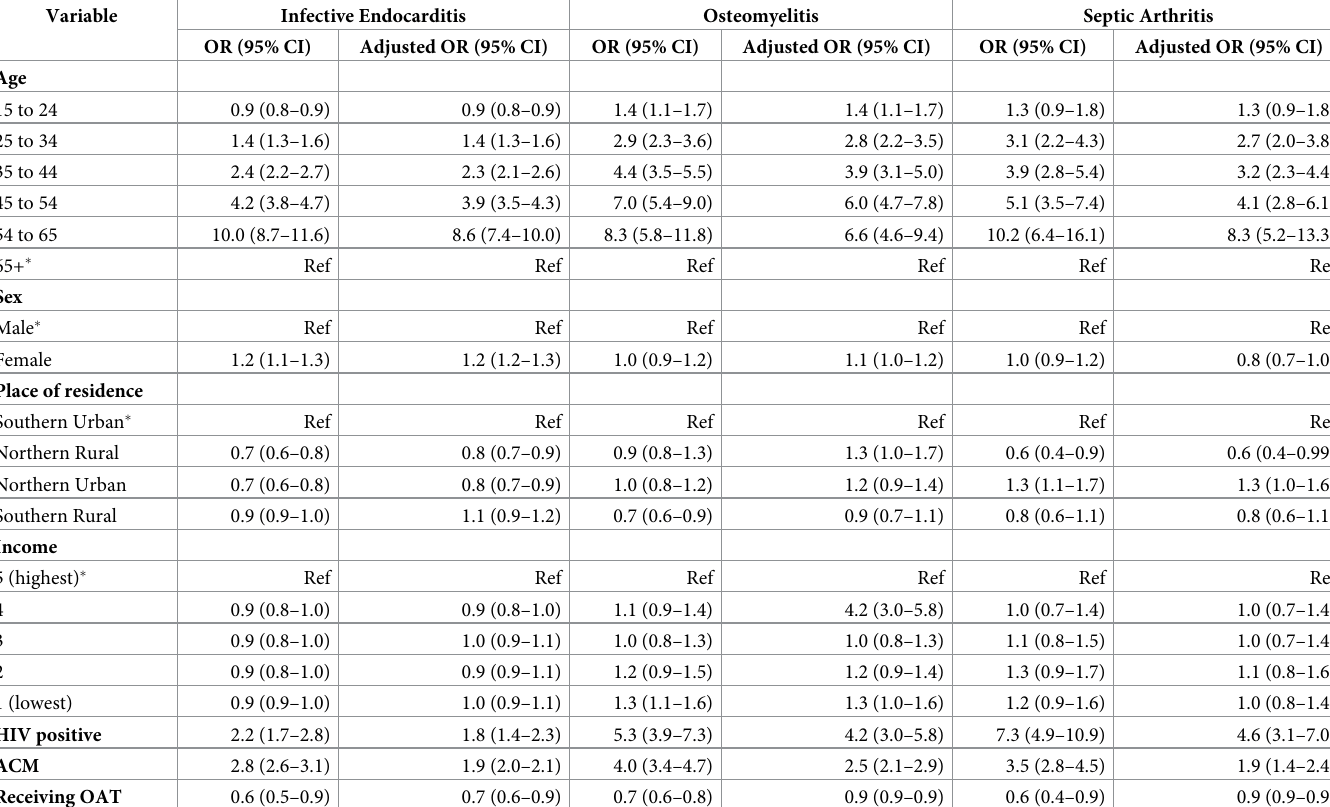
Table 3. Correlation between patient characteristics and deep tissue